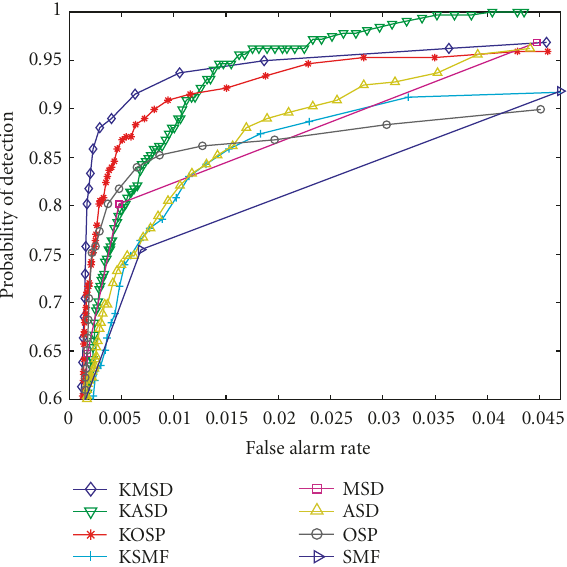
Figure 7: ROC curves obtained by conventional detectors and the corresponding kernel versions for the FR-I